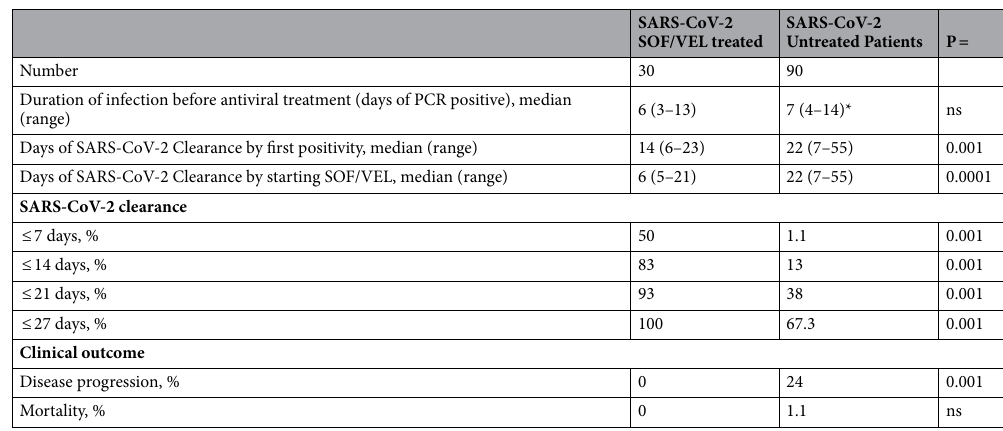
Table 2. SARS-CoV-2 clearance in patients treated with SOF/VEL and in untreated patients. *Days of SARS- CoV-2 positivity before enrolled in the study. ns not significant.